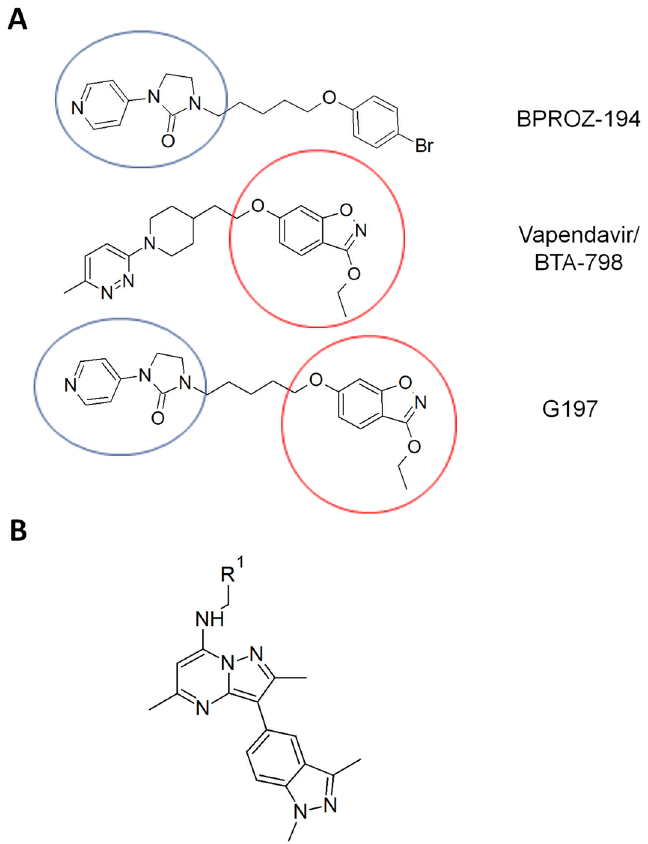
Figure 1. Chemical structures of G197 and N373. ( A ) G197 is a structural chimera of a capsid inhibitor reported by Shia et al. 13 (blue circle) and vapendavir (BTA-798) (red circle). ( B ) The general structure of N373 is as shown and R 1 represents the unique chemical group that is covered by patents owned by